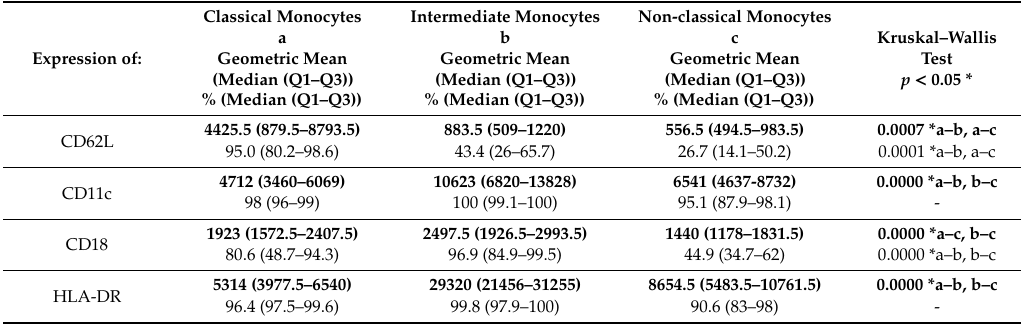
Table 3. Median proportion and median geometric means expression of CD62L, CD11c, CD18 and HLA-DR markers on three types of monocytes in study group. * p < 0.05 as statistically significant.